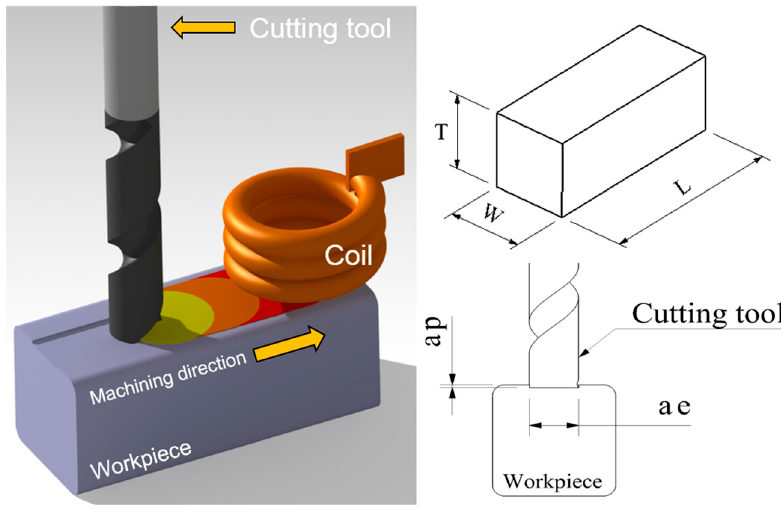
Figure 1. The schematic diagram of induction assisted milling.